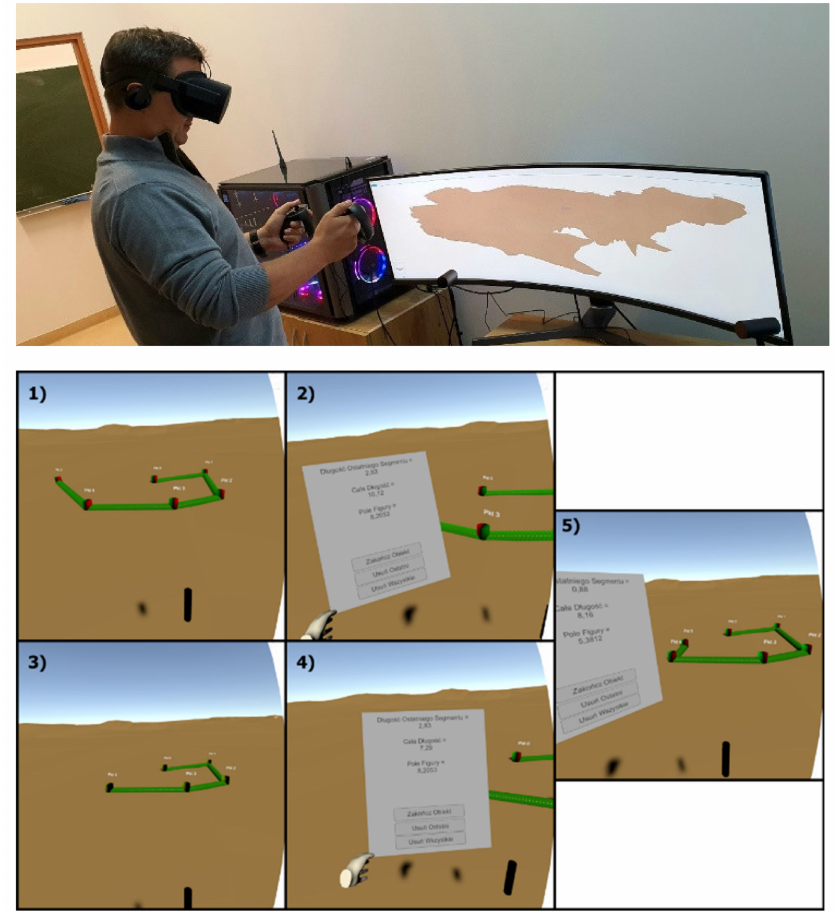
Figure 10. Optimisation of marking location and verification of hazardous area signs based on DEM of the bottom using self-developed VRGIS app. Screens from Oculus Rift with motion controllers: ( 1 ) The new point creation. ( 2 ) Settings new attributes for created point. ( 3 ) Removing existing points. ( 4 ) Display all values after deleting one point. ( 5 ) Display all values after adding one point and refresh the